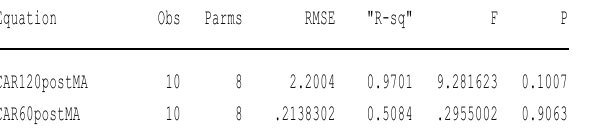
Table G1. Testing the relationship between BSC perspectives and CAR 60&120